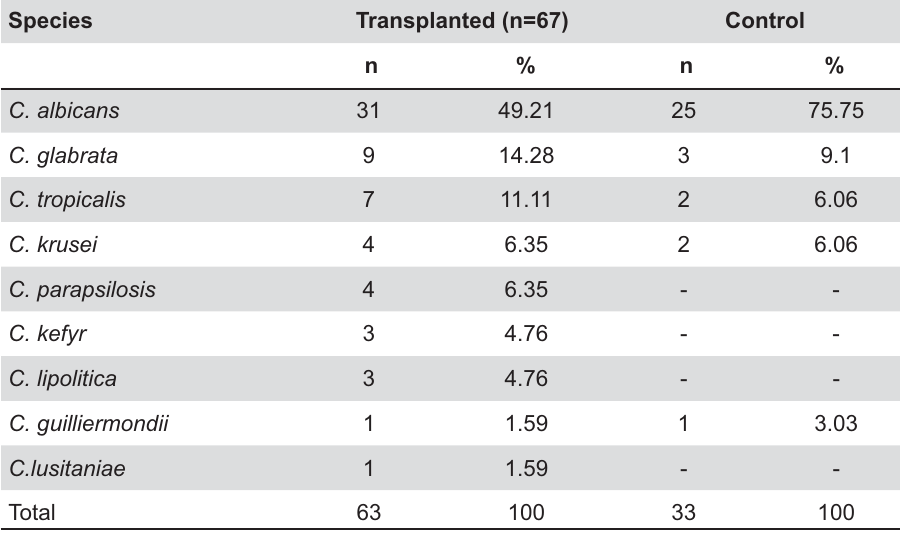
Table 3- Candida species isolated from the oral cavity of orthotopic cardiac transplantation patients and species isolated from the oral cavity of control